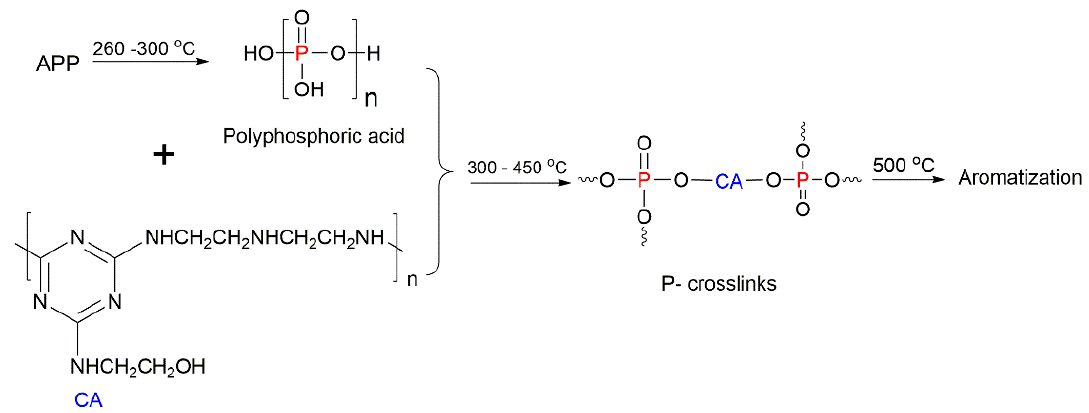
Figure 10. A char-forming mechanism in the ammonium polyphosphate/carbonisation agent (APP/CA) system [75].